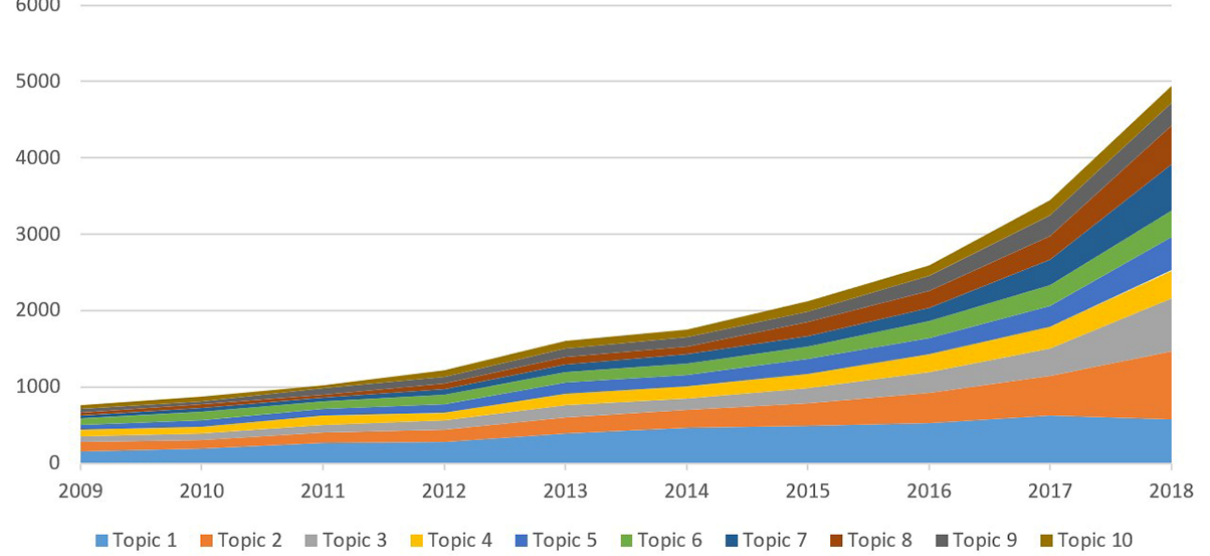
Figure 1. Changes in the applications of artificial intelligence to health and medicine in the past 10